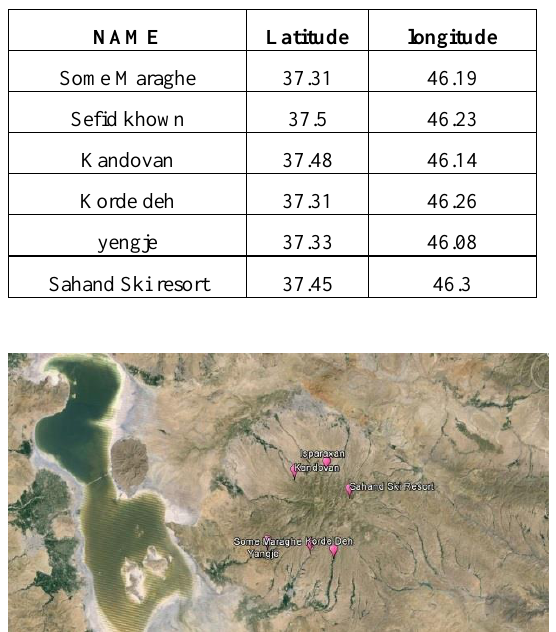
TABLE (1) Ground station name and coordinates